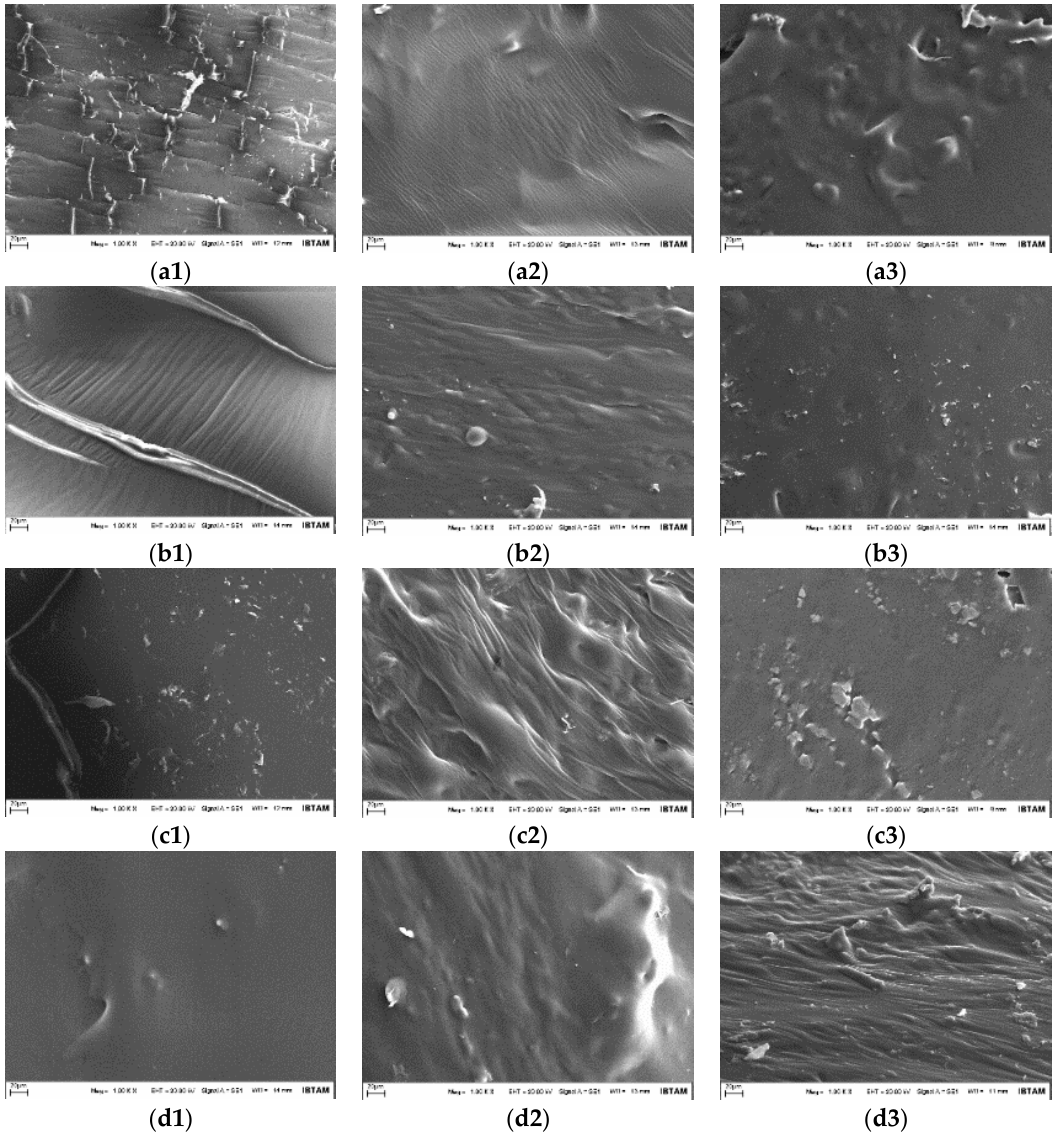
Figure 6. SEM images (1.0 K magnification, 20 kV voltage and 20 µm zooming) of bitumen samples before and after aging process: ( a ) B; ( b ) B+0.4R; ( c ) B+0.8R; ( d ) B+1.2R, for ( 1 ) un-aged (original); ( 2 ) RTFOT-aged; and ( 3 ) PAV-aged.